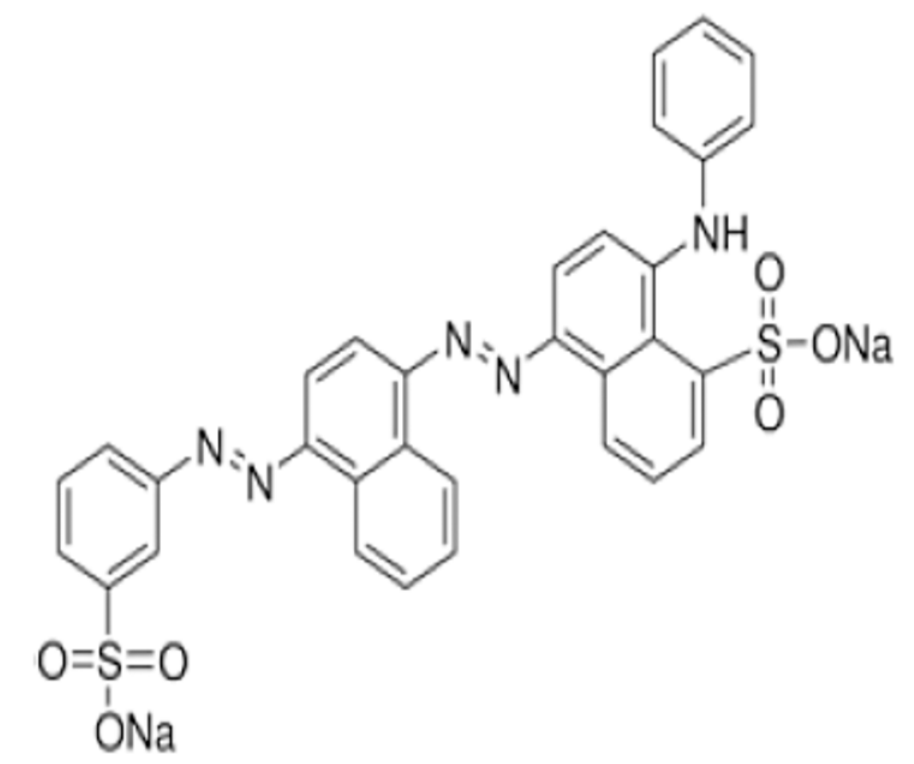
Fig 1. Chemical Structure of Acid Blue